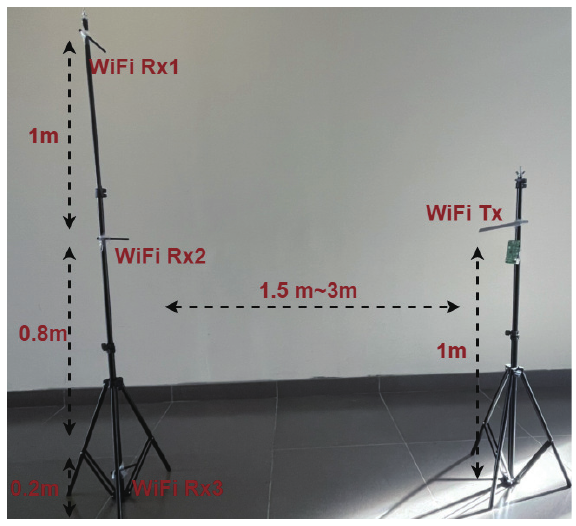
Figure 17. The experimental environment with three pairs of WiFi transmitter and receivers.